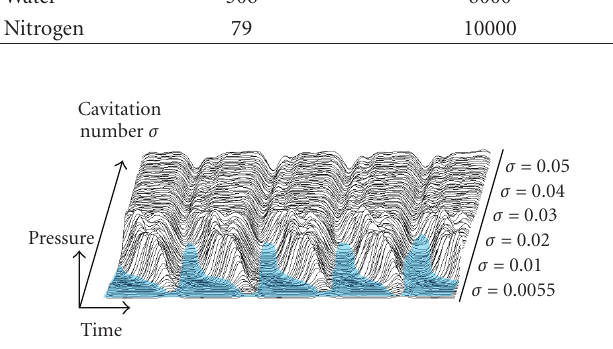
Figure 4: Waterfall of unsteady pressure